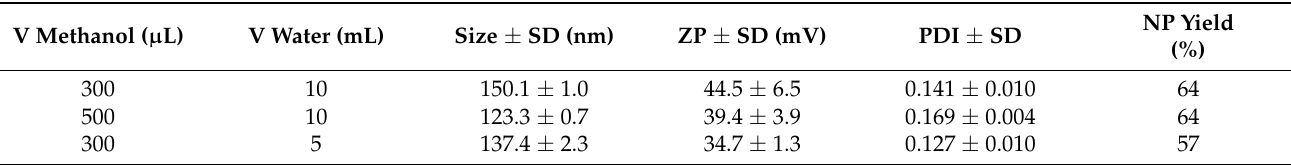
Table 3. Nanoprecipitation protocol optimization in view of colloidal properties and encapsulation yield of CFX–DOTAU